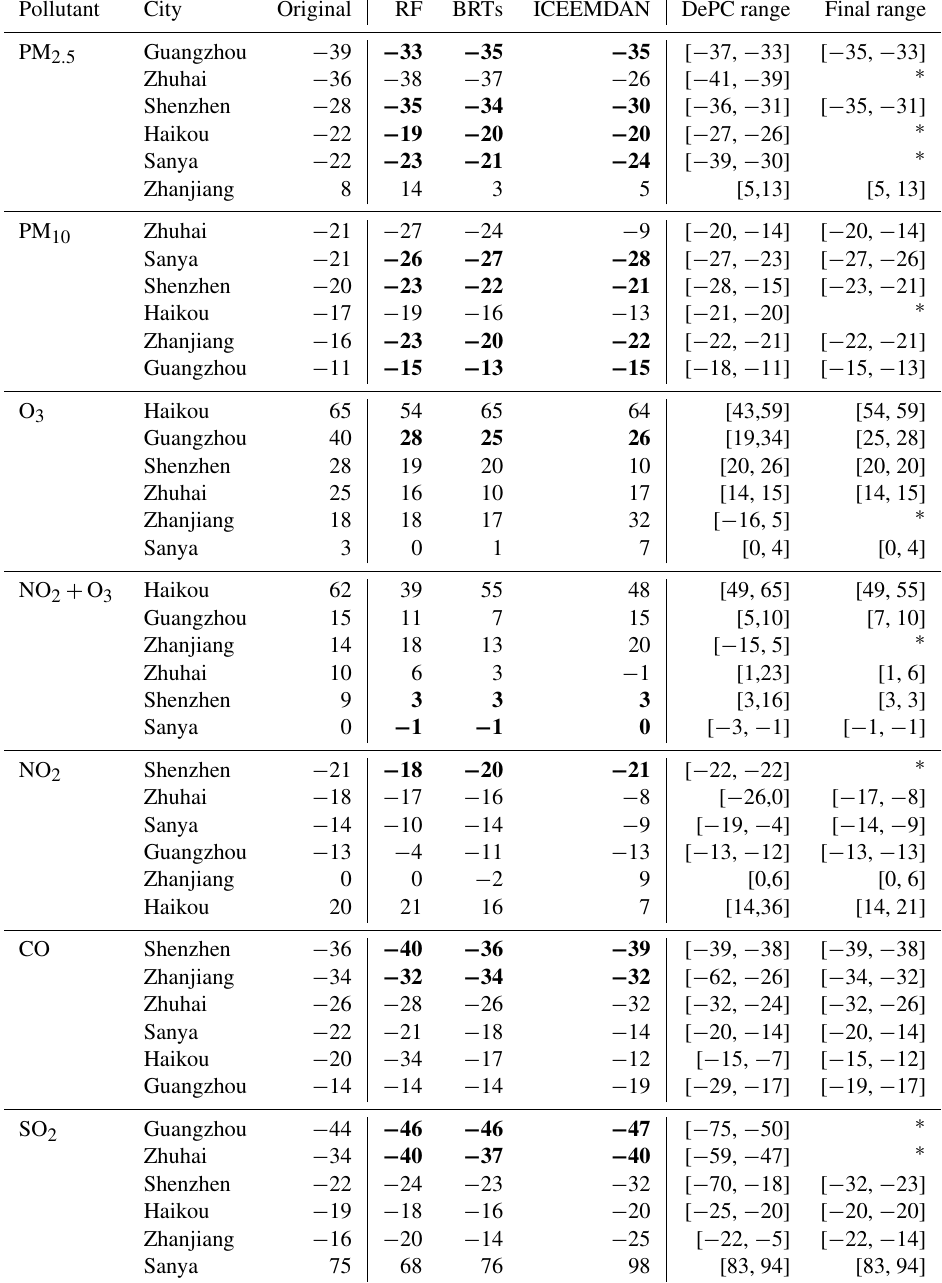
Table 2. The PCs of six criteria pollutants and NO 2 + O 3 calculated from original averages, RF-deweathered and BRT-deweathered concen- trations and ICEEMDAN-decomposed residuals and the robust ranges of DePC in six cities (units: %; ∗ represents no robust DePC). The bolded numbers represent consistent PCs calculated from three